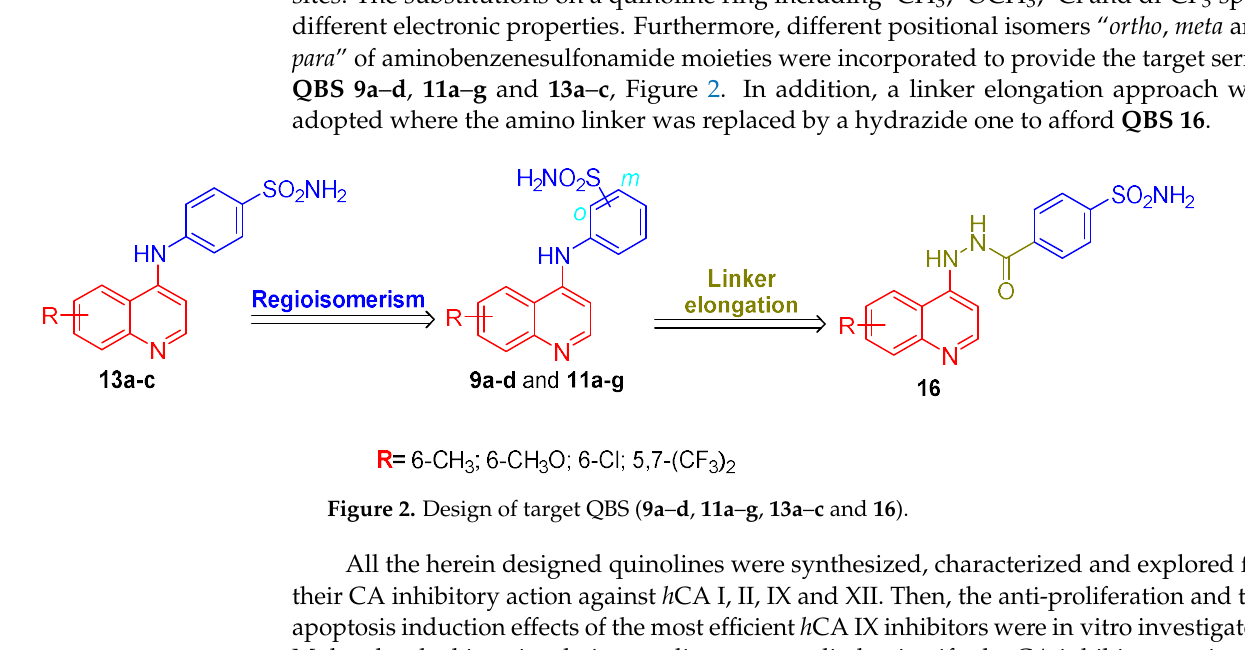
Figure 2. Design of target QBS ( 9a–d , 11a–g , 13a–c and 16 ).